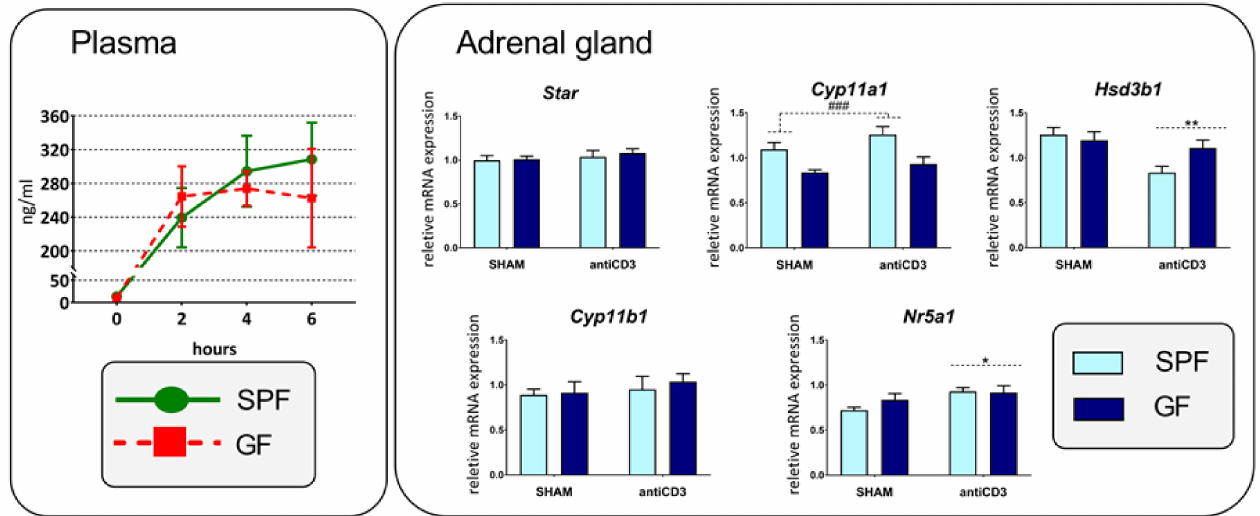
Figure 6. Effect of microbiota and acute immune stress on plasma concentration of corticosterone and the expression of genes participating in adrenal steroidogenesis. SPF, specific pathogen-free mice; GF, germ-free mice; SHAM, mice injected with saline; anti-CD3, mice injected with anti-CD3 antibody; Star , steroidogenic acute regulatory protein; Cyp11a1 , cholesterol side-chain cleavage enzyme; Hsd3b1 , 3 β -hydroxysteroid dehydrogenase type 1; Cyp11b1 , 11 β -hydroxylase; Nr5a1 , steroidogenic factor 1. The data are expressed as means ± SEM. Two-way ANOVA revealed main effect of time on plasma concentration of corticosterone (microbiota: NS; time: F 3,32 = 31,98, p < 0.001; microbiota*time: NS), microbiota on Cyp11a1 (microbiota: F 1,34 = 17.14, p < 0.001; stress: NS, microbiota*stress: NS), and anti-CD3 stress on Nr5a1 (microbiota: NS; stress: F 1,34 = 5.85, p = 0.021; microbiota*stress: NS) and Hsd3b1 (microbiota: NS; stress: F 1,34 = 8.91, p = 0.005; microbiota*stress: NS). A main effect of microbiota has been marked by placing a dashed horizontal line with a hash sign ( ### p < 0.001) above the bars for the SPF groups, whereas a main effect of stress has been marked by placing a dashed horizontal line with an asterisk (* p < 0.05, ** p < 0.01) above the bars for the stress-exposed